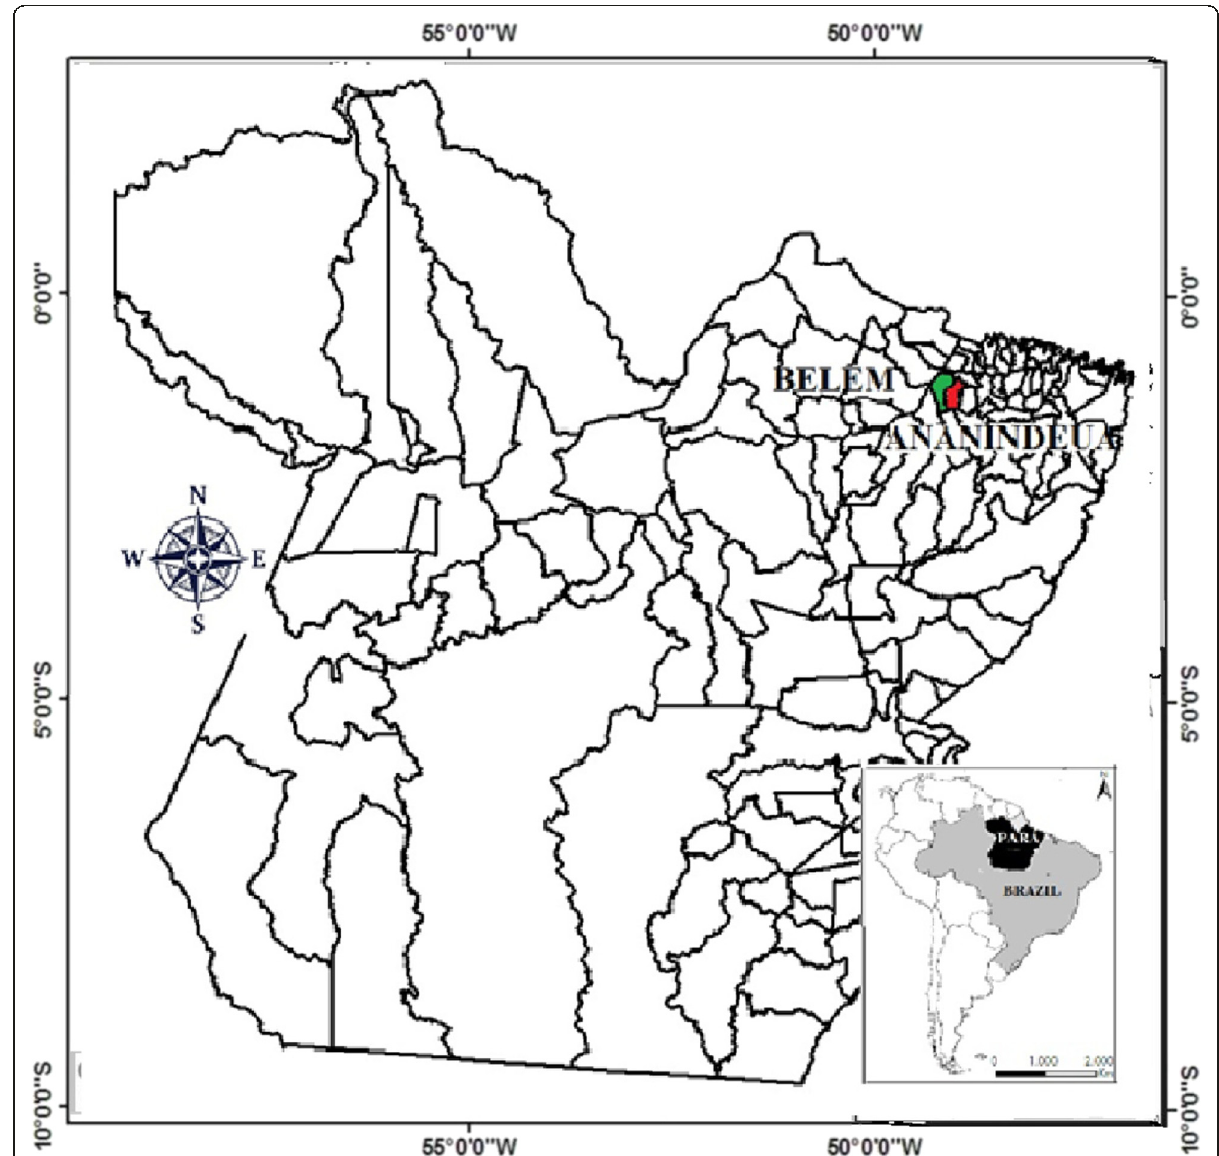
Fig. 1 Study areas in Pará state, northern Brazil: Belém (green) and Ananindeua (red)